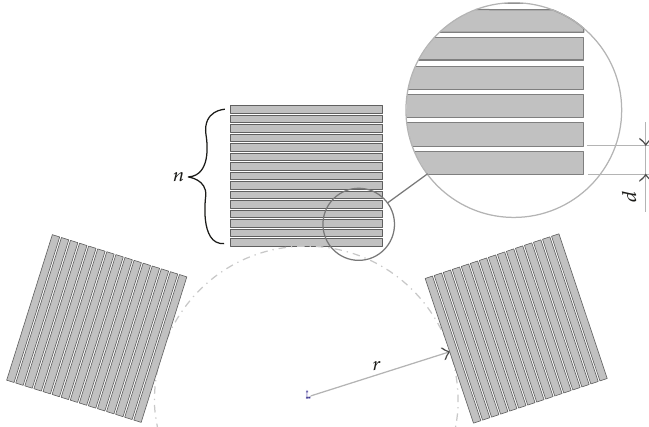
Figure 5: Simplified schematic of the cable’s cross-section used to describe the design variables n (number of tapes per slot), d (spacing between two consecutive tapes), and r (off-center distance of the inner tape) used in the optimization process.